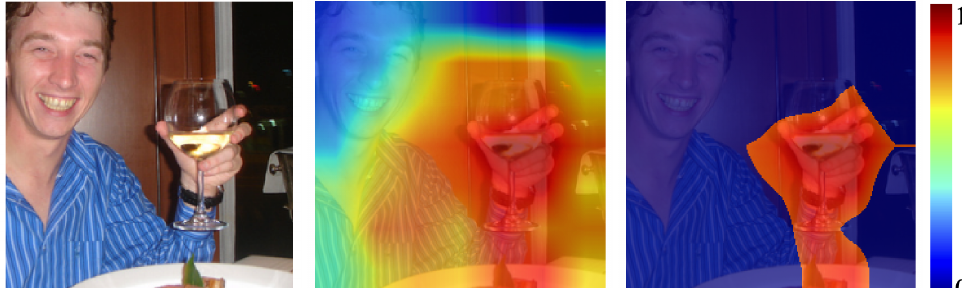
Figure 1. An example of input attribution and thresholding. ( Left ) An original image from Pascal VOC 2012; ( middle ) the Grad-CAM attribution map computed from ResNet-50 overlaid with the original image; ( right ) the attribution map produced by our threshold fine-tuning